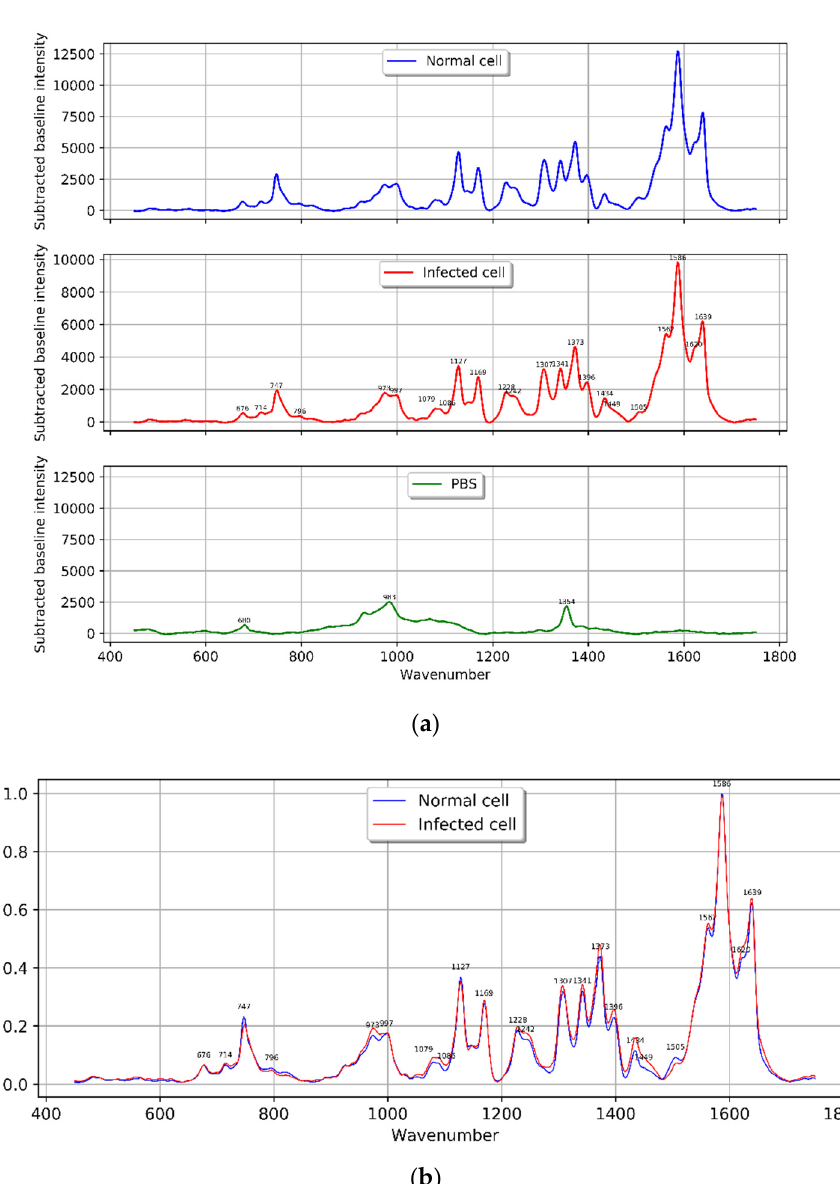
Figure 5. Analysis of Raman spectrum intensity for normal and P. falciparum (3D7)-infected red blood cell. ( a ) Averaged normal red blood cells spectra ( n = 460) and infected red blood cells spectra ( n = 365) in comparison to PBS buffer. ( b ) Averaged, normalized spectra from normal red blood cells ( n = 460) and infected red blood cells spectra ( n = 365).